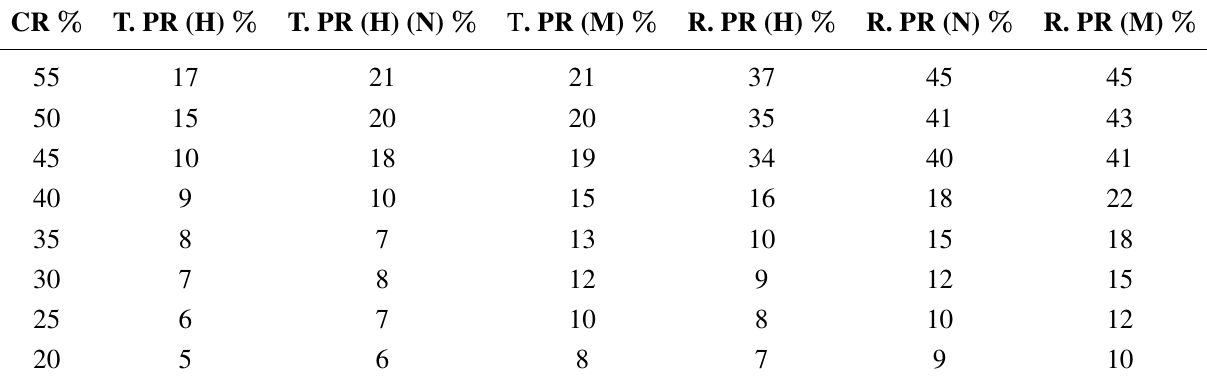
Table 13. Comparison on power reduction based on